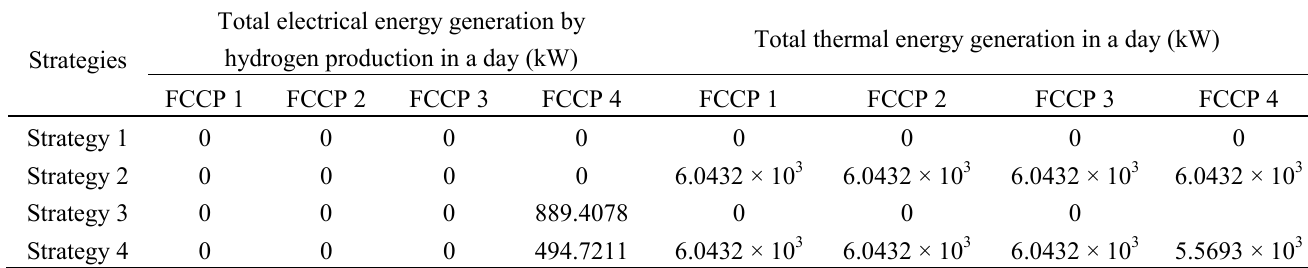
Table 8. Results obtained for thermal energy & hydrogen production for FCPPs by multi objective